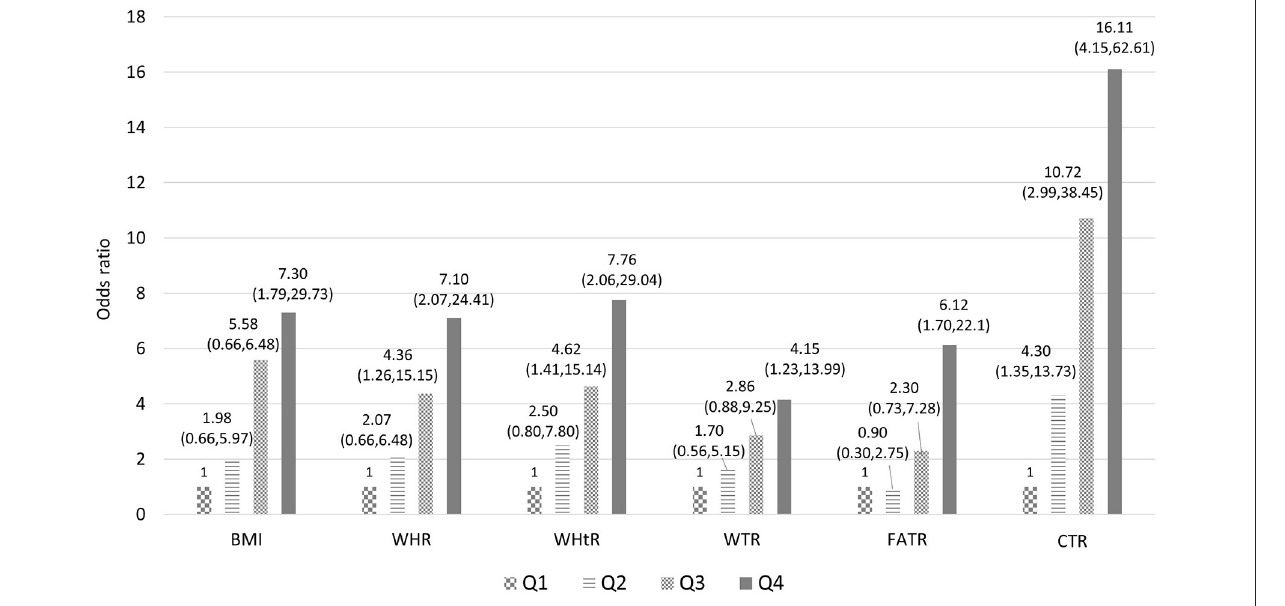
FIGURE 1 | Association between the selected combination of body measurements and T2DM (model includes age, sex, occupation, education, marriage, smoking, alcohol drinking, tea drinking, coffee drinking, betel nut chewing, daily activity level, adiponectin, leptin, and quartile of selected body measurements combination. BMI body mass index; WHR, waist-to-hip ratio; WHtR, waist-to-height ratio; WTR, waist-to-thigh ratio; FATR, forearm-to-thigh ratio; CTR, calf-to-thigh